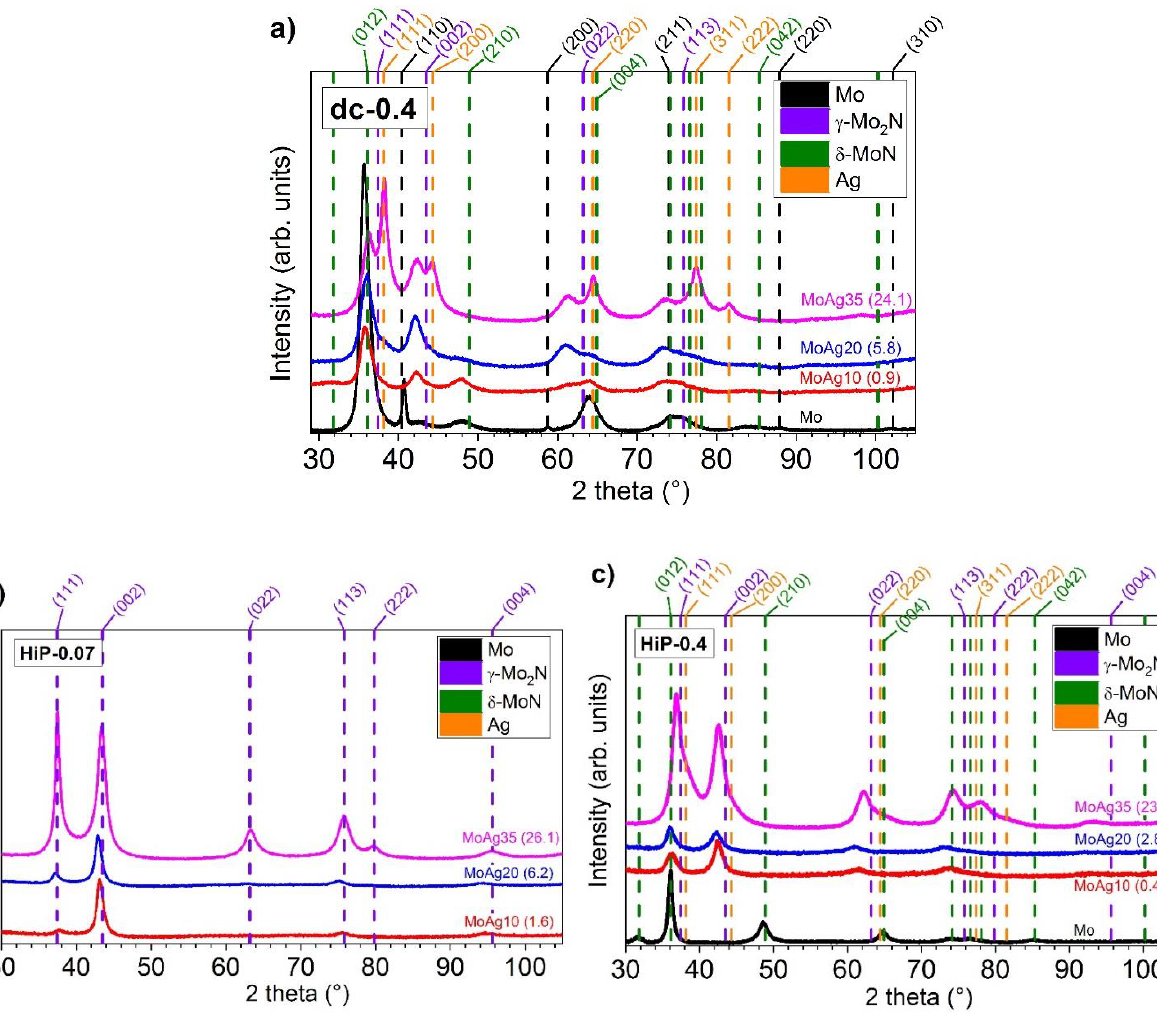
Figure 9. XRD patterns of Mo x N and MoN-Ag films: ( a ) series dc-0.4, ( b ) series HiP-0.07 (the Ag-Figure 2. N film is missing) and ( c ) series HiP-0.4. The main X-ray peaks of Mo, γ -Mo 2 N, δ -MoN and Ag have been included as vertical dashed lines. The Ag content of the coatings is added in brackets (in at.%) to the MoAg target materials.